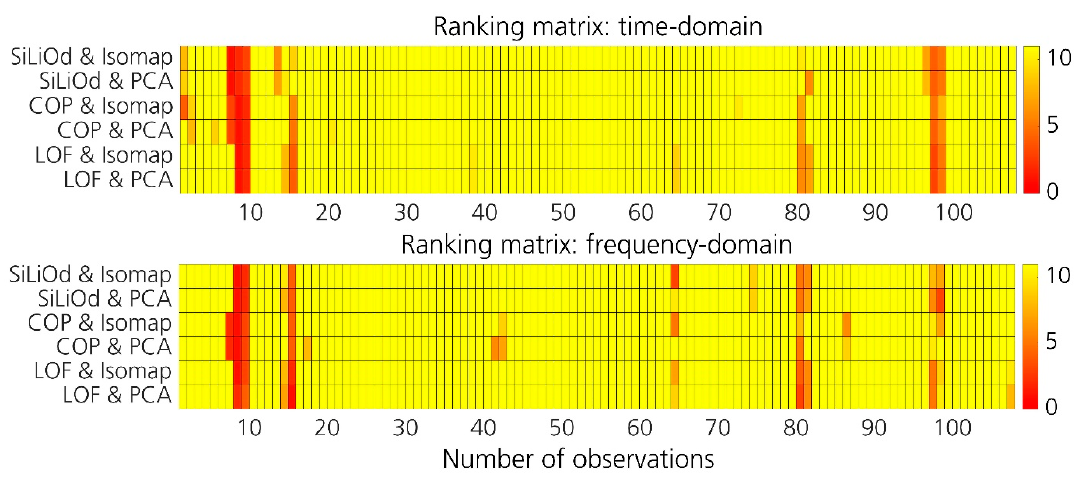
Figure 15. Total ranks for time-domain ( top ) and frequency-domain ( bottom ) features.